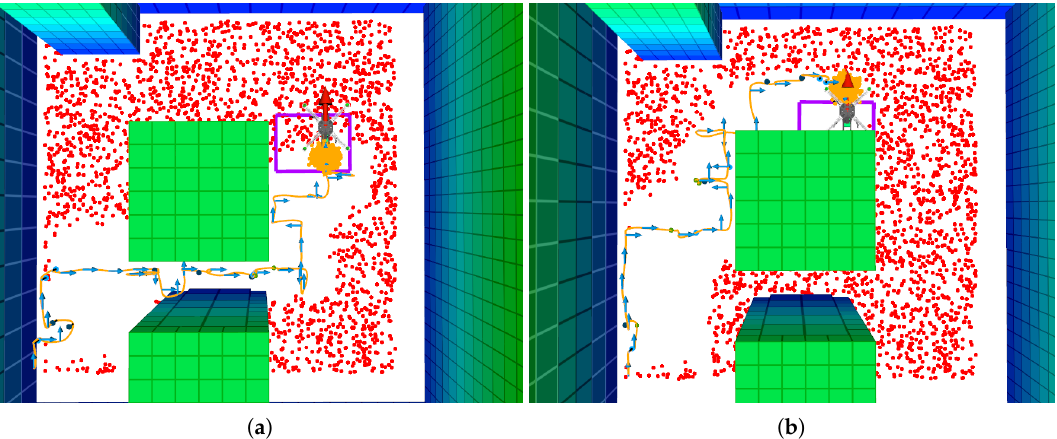
Figure 12. Example global trajectories followed by the UAV under a uniform belief cluster in flight tests. ( a ) Motion policy that encourages the UAV to cross over the column obstacles. ( b ) Motion policy that encourages the UAV that avoids crossing over the column